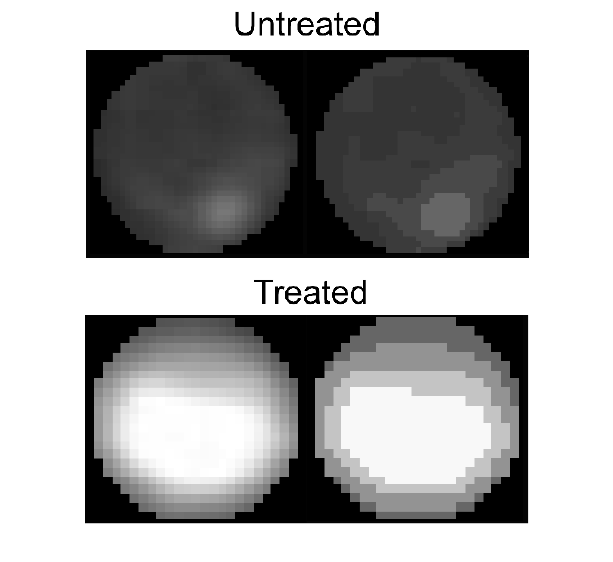
FIGURE 7: Data clustering. Non-apoptotic (top) and apoptotic (bottom) nuclei before and after the clustering to 4 brightness groups. For the calculation of the intensity and effective radius parameters: in the non-apoptotic nucleus the nucleolus pixels are not counted, in the apoptotic nucleus only the brightest cluster is